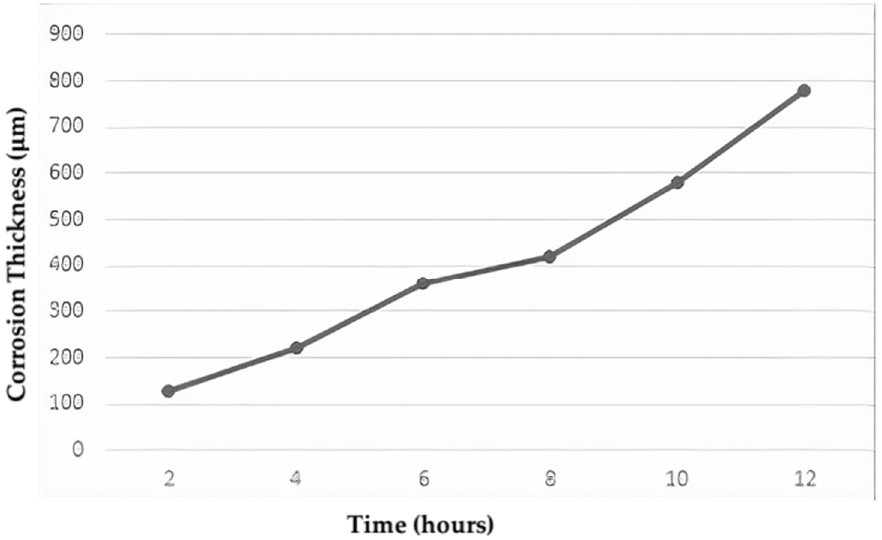
Figure 4. Changes in corrosion thickness according to time. After 12 h of corrosion, the corroded thickness can reach 800 μm. Table 6. S41C specimen fabrication methods.